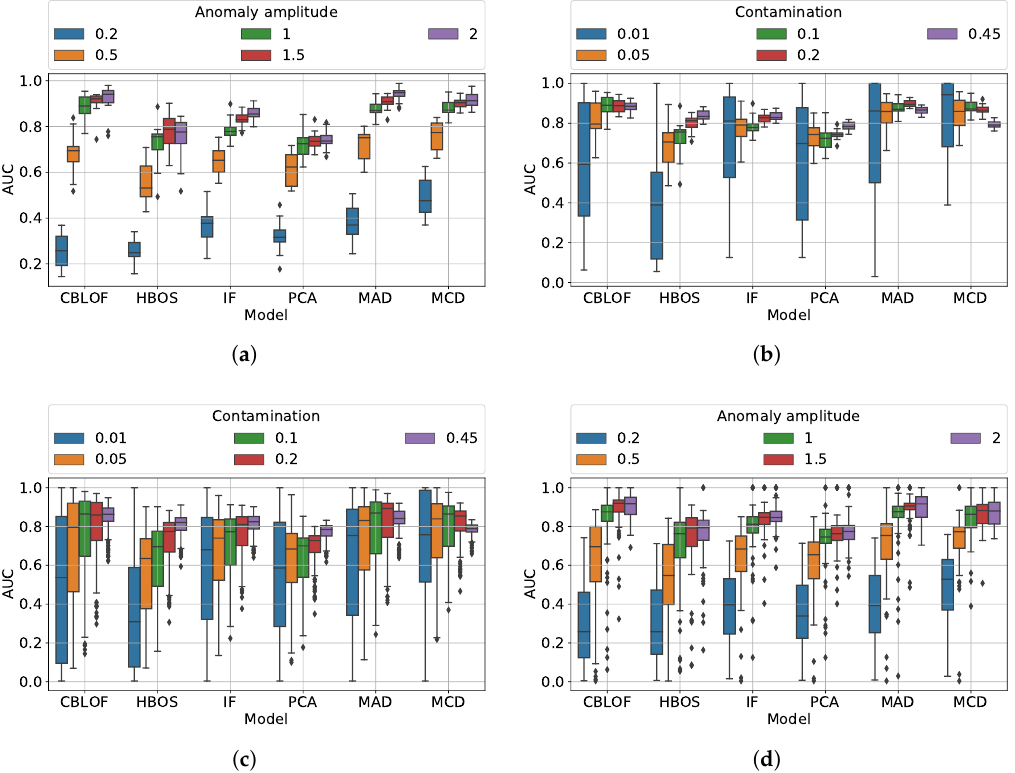
Figure 9. Precision degradation. ( a ) Fixed contamination %10. The anomaly amplitude varies. ( b ) Fixed anomaly amplitude 1. The contamination varies. ( c ) General case, where both the anomaly amplitude and the contamination vary. Contamination view. ( d ) General case, where both the anomaly amplitude and the contamination vary. Anomaly amplitude view.